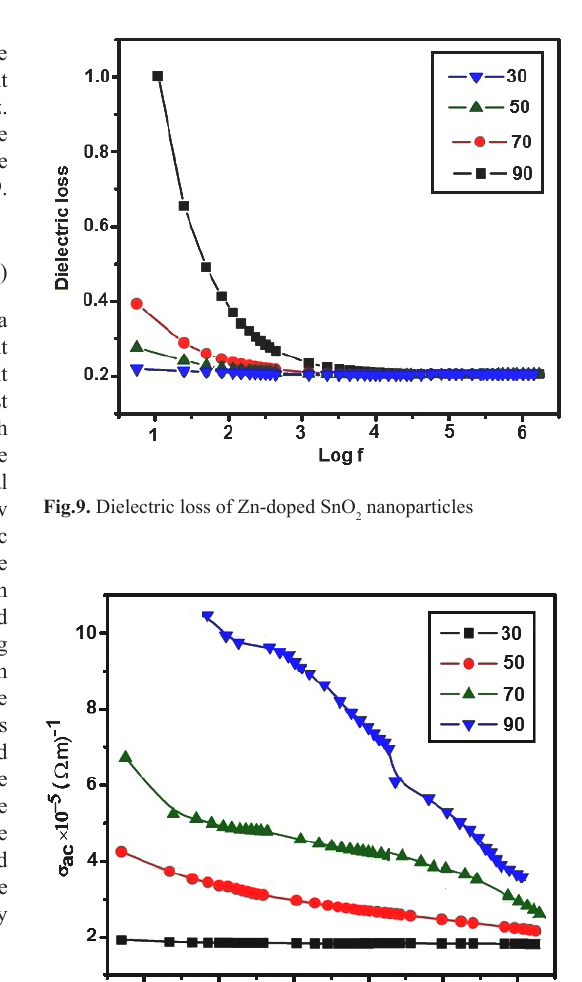
Fig.10. Variation of ac conductivity with frequency at various temperatures